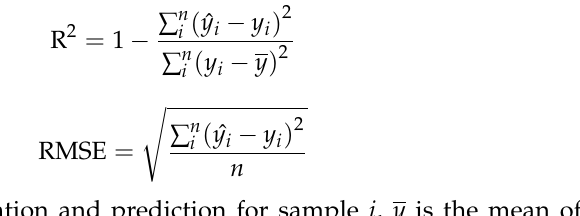
Table 1, GA is applicable to different algorithms. The GA algorithm was performed in R package